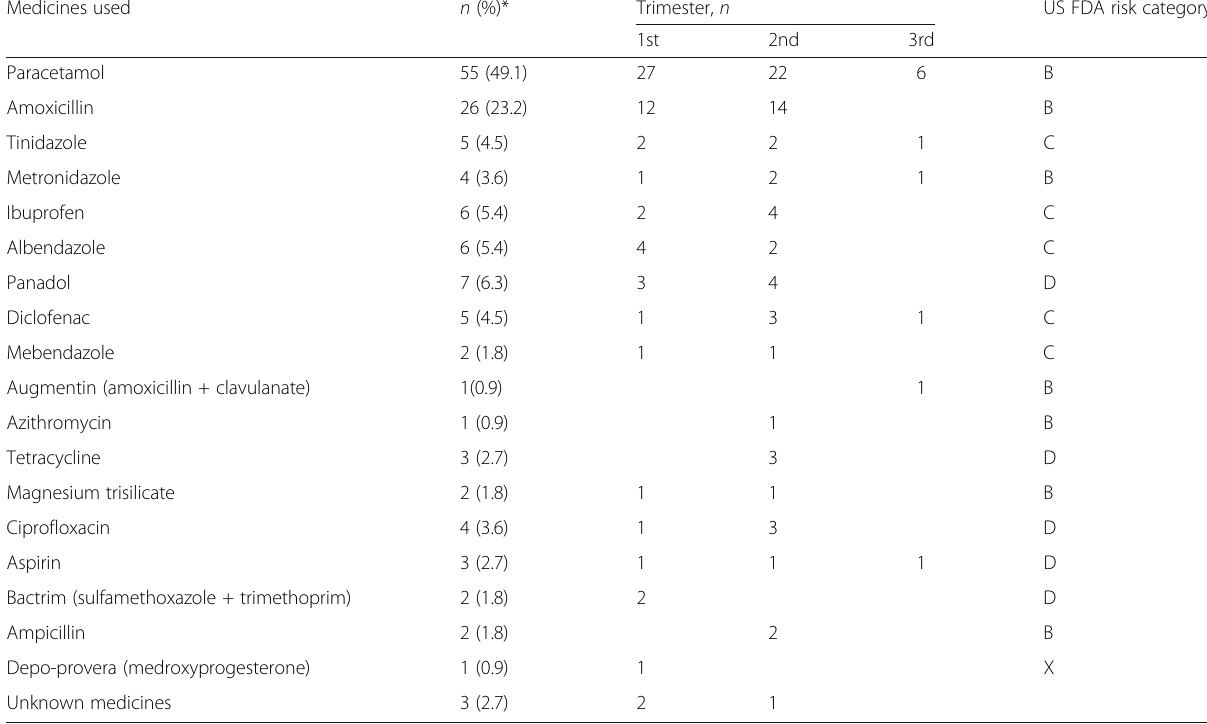
Table 5 Modern medicines used for self-medication by pregnant women by trimester and US FDA pregnancy risk classification, Addis Ababa, 2017 ( n = 112) Medicines used